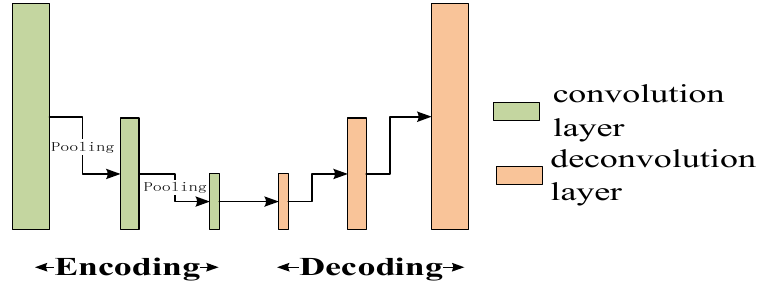
Figure 2. U-Net Structure.